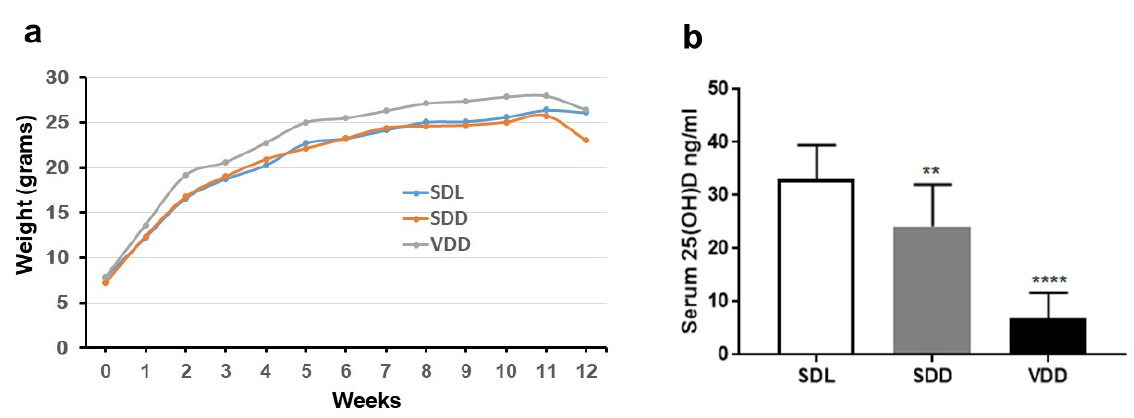
Figure 4. Effect of a VD-deficient diet on weight and VD serum levels. Diets containing 25 IU/kg-VD3 (VD3, deficient diet) or 1000 IU/kg (standard diet) were administered to approximately 4-month-old mice ( n = 7/group) to assess their effects on serum 25(OH)D and weight. ( a ) VDD mice gained more weight than the controls. ( b ) VDD mice exhibited a significant reduction in 25(OH)D serum concentration presented as the mean (ng/mL) ± SD. A one-way ANOVA was used for the serum 25(OH)D analysis and a two-way ANOVA was performed for the weight analysis. ** p < 0.01, **** p <